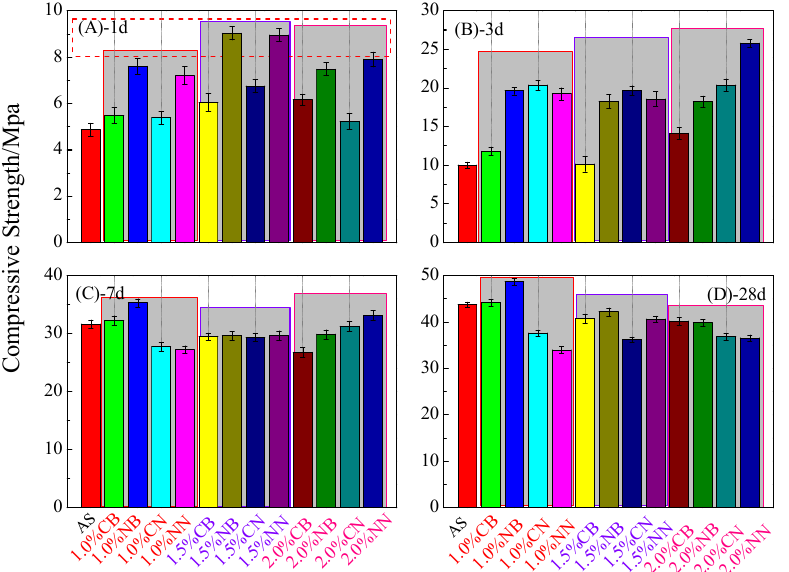
Figure 3. Effects of inorganic salts on the strength at 10 °C: ( A ) curing for 1 day; ( B ) curing for 3 days; ( C ) curing for 7 days; ( D ) curing for 28 days.